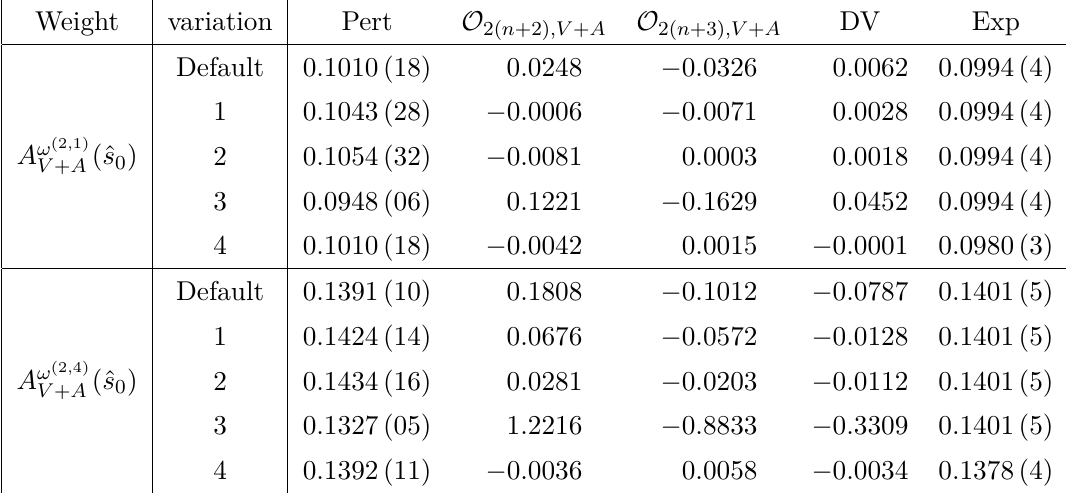
(ˆ s ) with n = 1 , 4 , together with their 0 V + A